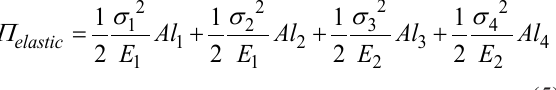
Fig. 4. Bilinear stress-strain relation. Material with inelastic stress-strain behaviour for ε j > ε y . At unloading for ε j > ε y stiffness is given by E